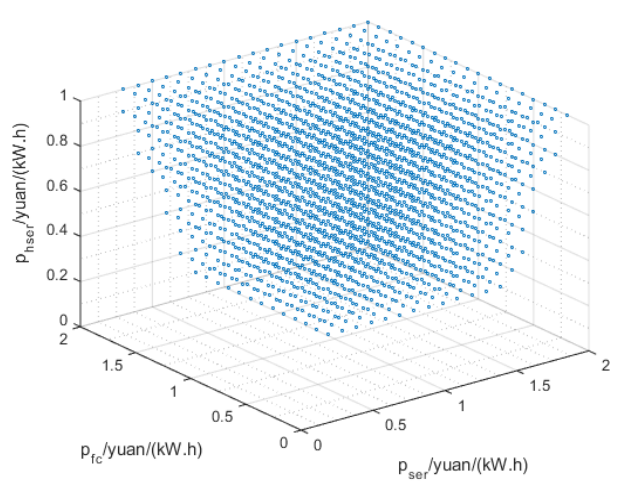
Figure 4. Nash equilibria of the tripartite game.